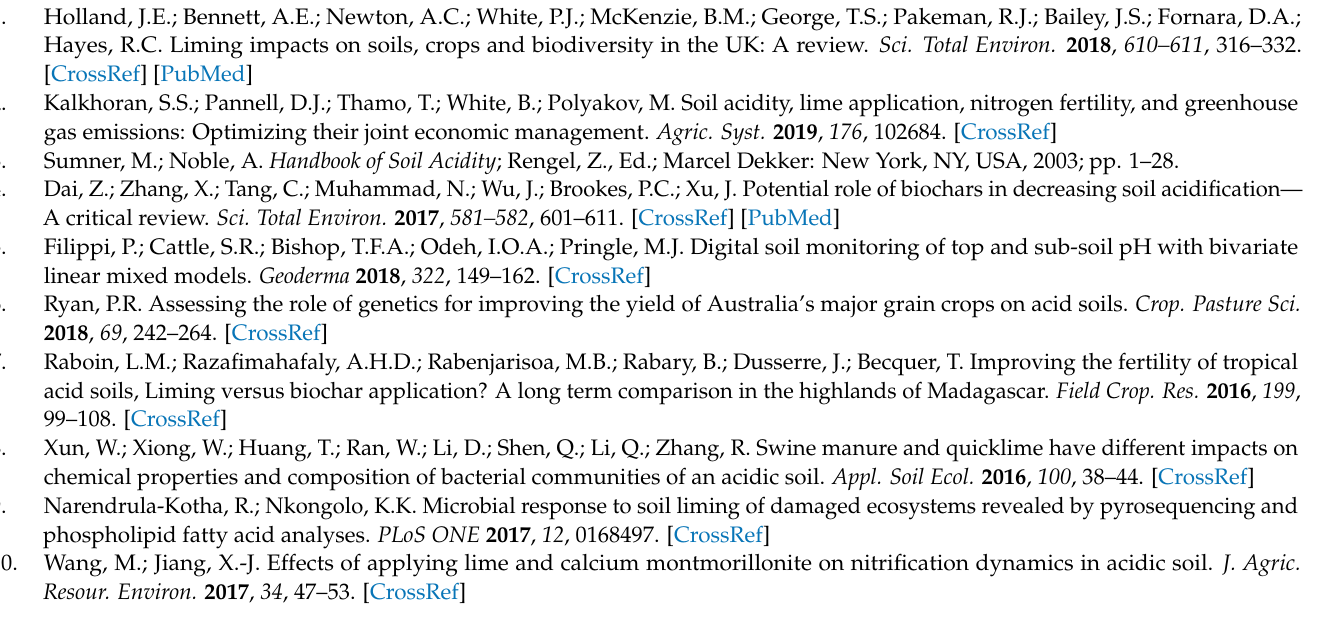
Table S2: Effect of different amendments on the nutrient concentration in acid soils (mean ± SE), Table S3: Effect of different amendments on the yield and nutrient concentration in maize plants (mean ±